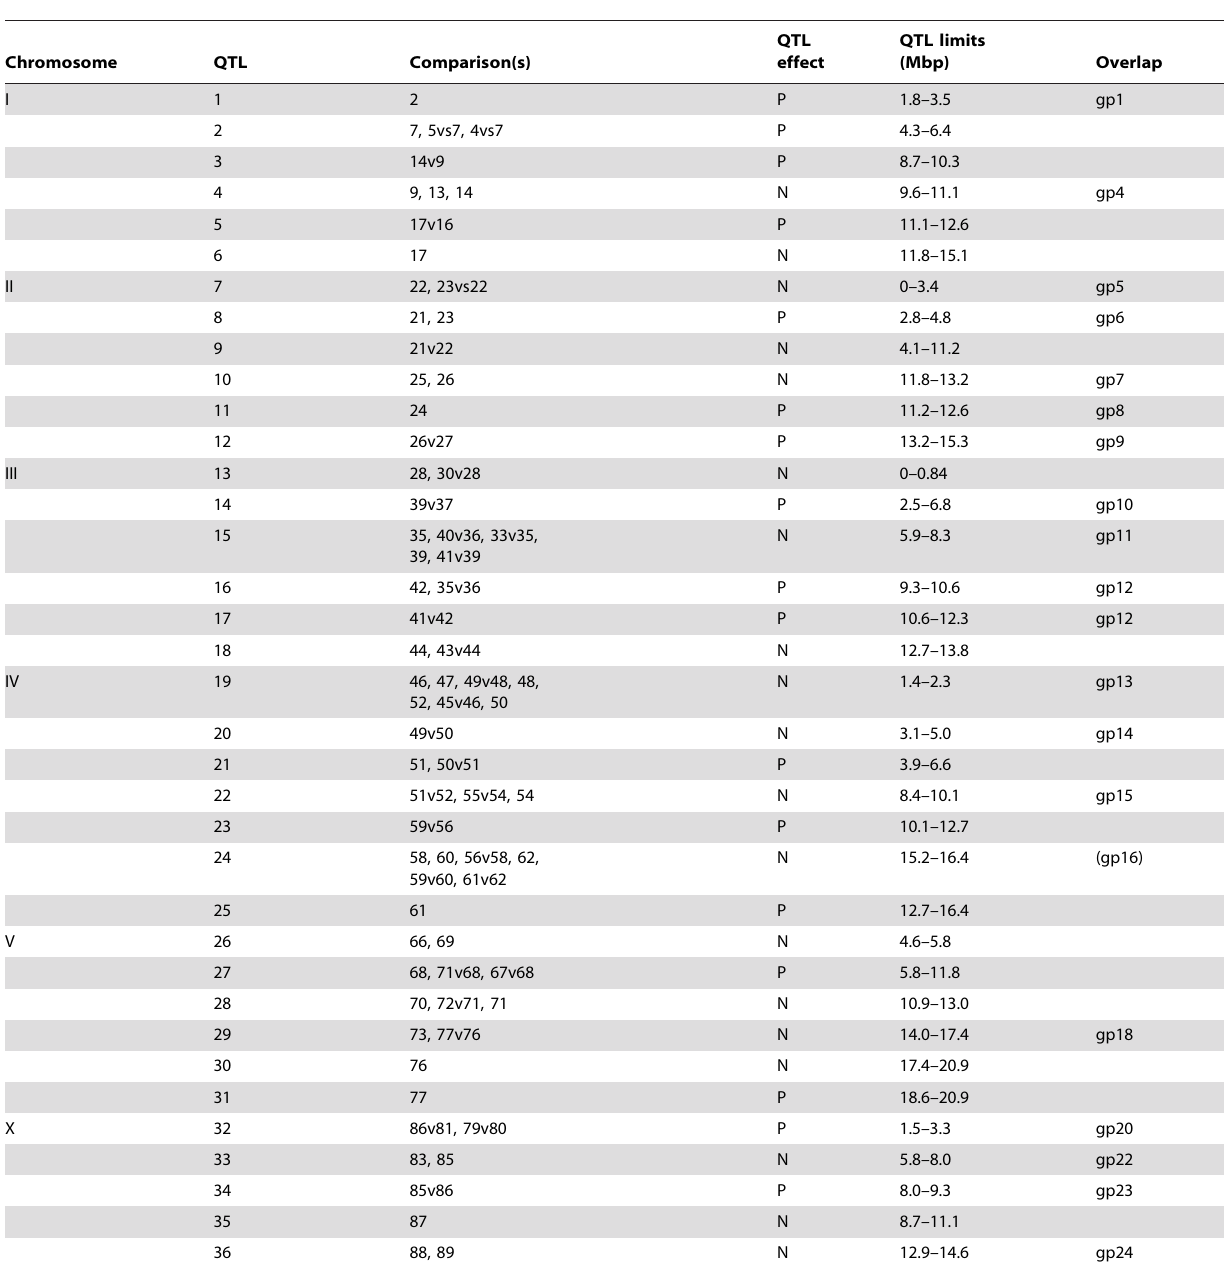
Table 2. Locations and effect of QTLs detected for dauer larvae formation in response to defined amounts of pheromone.